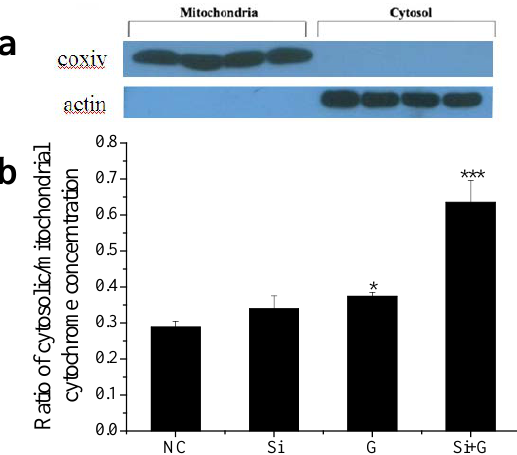
Figure 7. Effect of SelR gene knockdown on D -galactose-induced cytochrome c release. ( a ) Purity of cytosolic and mitochondrial fractions; ( b ) ELISA quantization of cytochrome c protein in cytosolic and mitochondrial fractions. The data are expressed as the ratio of cytosolic-to- mitochondrial cytochrome c concentrations. * p < 0.05, *** p < 0.001, compared to the negative control group. NC: negative control cells; Si: cells with SelR siRNA transfection for 24 h; G: cells exposed to D -galactose (150 mM) for 36 h; Si+G: cells with SelR siRNA transfection followed by D -galactose exposure.